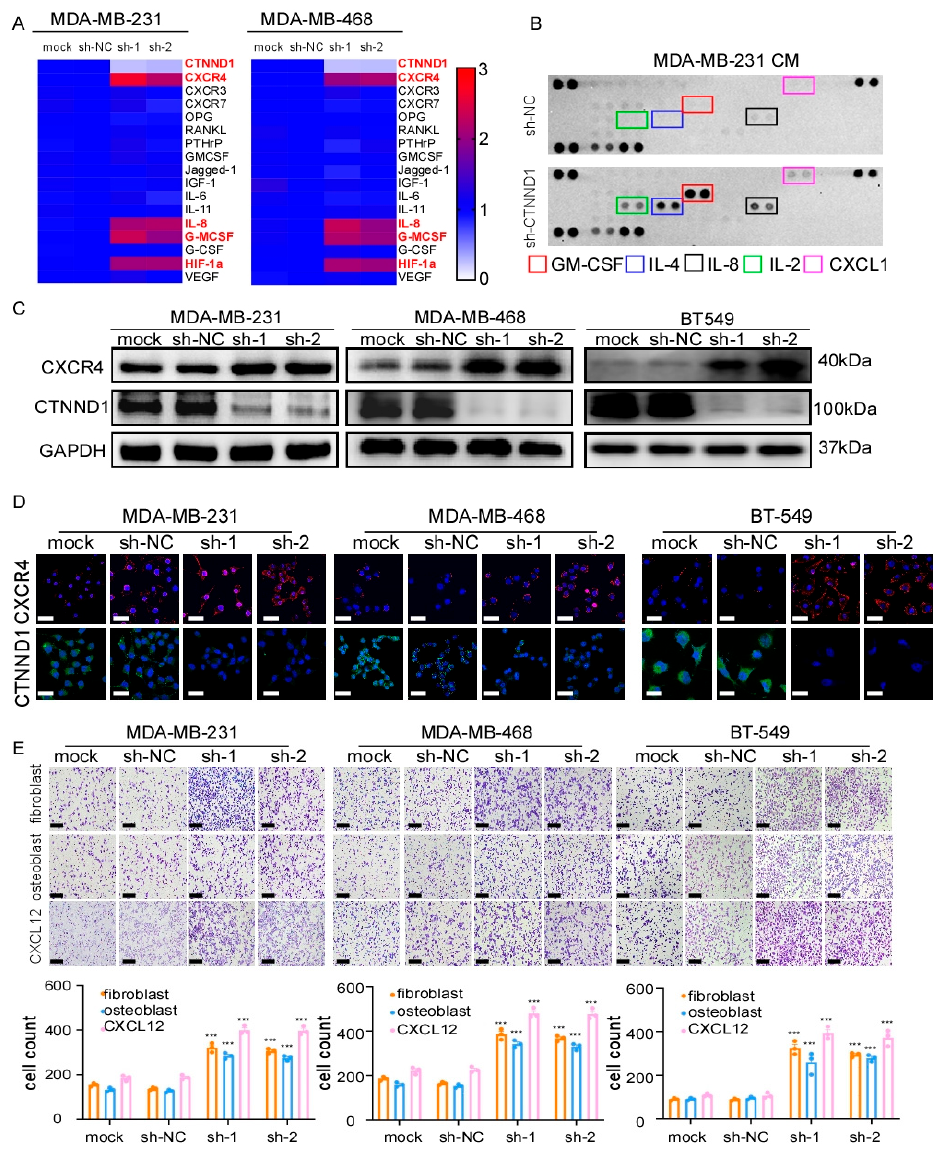
Figure 4. Reduction of CTNND1 upregulates the CXCR4/CXCL12 axis to facilitate TNBC cells homing to the bone. ( A ) Expression of bone metastasis-related genes was detected by qRT-PCR in human TNBC cell lines (MDA-MB-231, MBA-MB-468) with and without CTNND1 knockdown. The result was showed as a heatmap. ( B ) Cytokines secreted by MDA-MB-231 with CTNND1 knockdown were detected by human Cytokine Array Kit. ( C ) Immunoblotting of CXCR4 in TNBC cells with CTNND1 knockdown. ( D ) Immunofluorescence of CXCR4 in TNBC cells with CTNND1 knockdown. Scale bar = 50 μ m. ( E ) Images and quantification of chemotaxis of TNBC cells with CTNND1 knockdown, fibroblast (upper panel), osteoblast (middle panel), CXCL12 (lower panel) in bottom chamber, respectively. Scale bar = 200 μ m. *** p < 0.005. Error bars indicate Standard Error of Mean (S.E.M.).